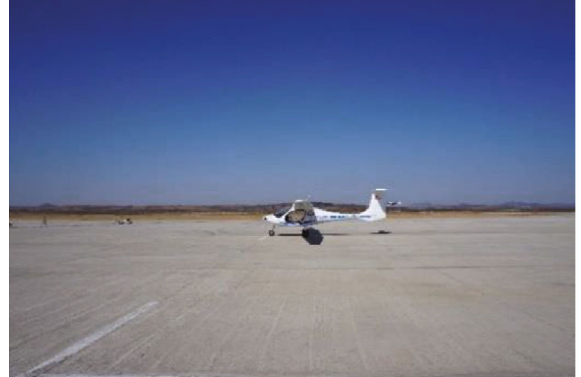
Figure 7: The experimental site.